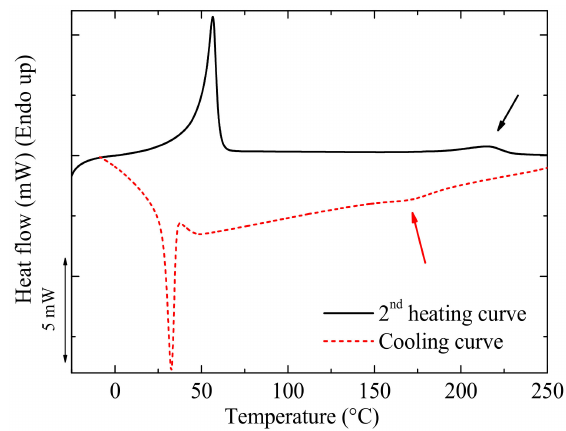
Figure 1. DSC (Differential Scanning Calorimetry) cooling and second heating curves for the selected 73/(23/4) w / w PCL/(PC/MWCNT) nanocomposite. The arrows indicate the crystallization and melting of the PC-rich phase in the